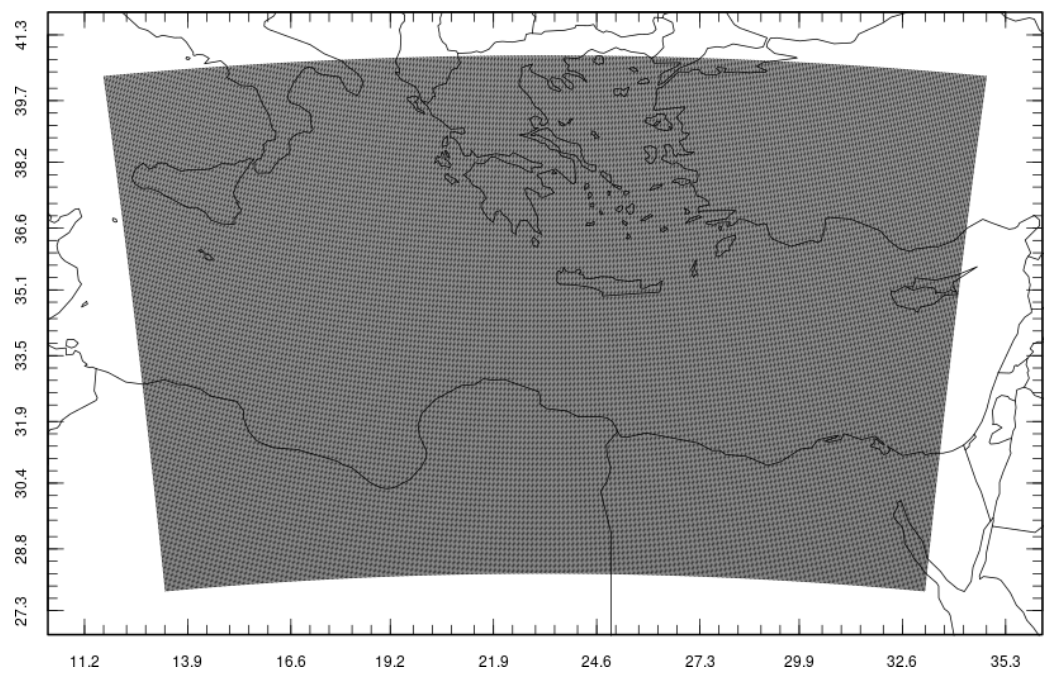
Figure A2. The CHIMERE simulation domain contains 874 × 624 cells at a 2.25km resolution.